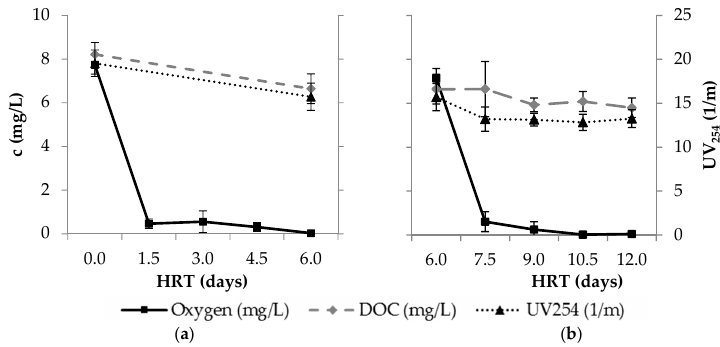
Figure 2 . DOC, oxygen and UV 254 absorbance ( a ) in the first column as an average from four different systems and ( b ) in the second filtration step after aeration with air ( n ≥ 5).